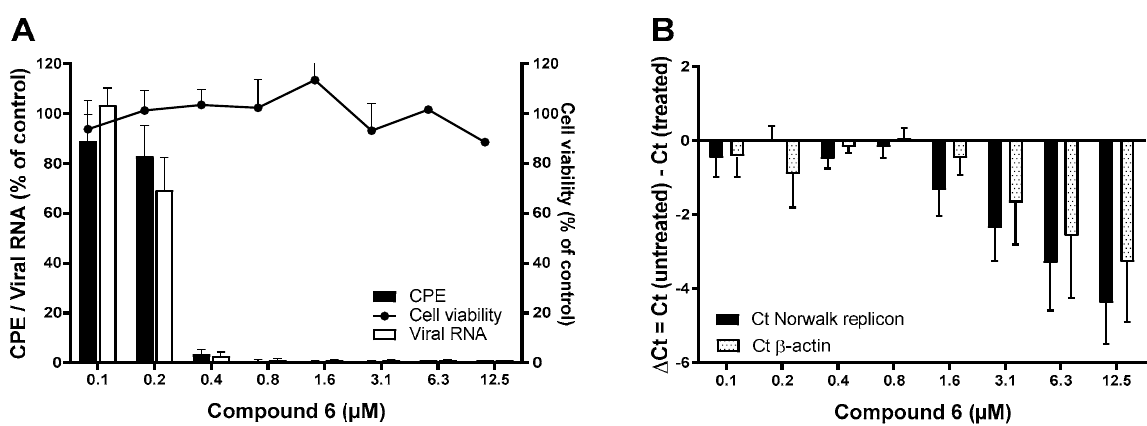
Figure 2. The antiviral effect of compound 6 against MNV and the HuNoV GI.1 replicon. ( A ) The antiviral activity of compound 6 was quantified by means of (i) virus ‐ induced CPE reduction assay using a colometric read ‐ out (black bars) and (ii) viral RNA levels using RT ‐ qPCR (empty outlined bars). Results are mean values (±SEM) of 6 independent experiments. Potential adverse effects on the host cells were assessed in parallel and quantified by a colometric assay (black dots). Results are mean values (±SEM) of 2 independent experiments. ( B ) The antiviral activity of compound 6 against the HuNoV GI.1 replicon was quantified by RT ‐ qPCR. Intracellular RNA loads are represented by absolute genome quantification of the HuNoV GI.1 replicon versus β‐ actin. Results are mean values (±SEM) of 8 independent experiments.